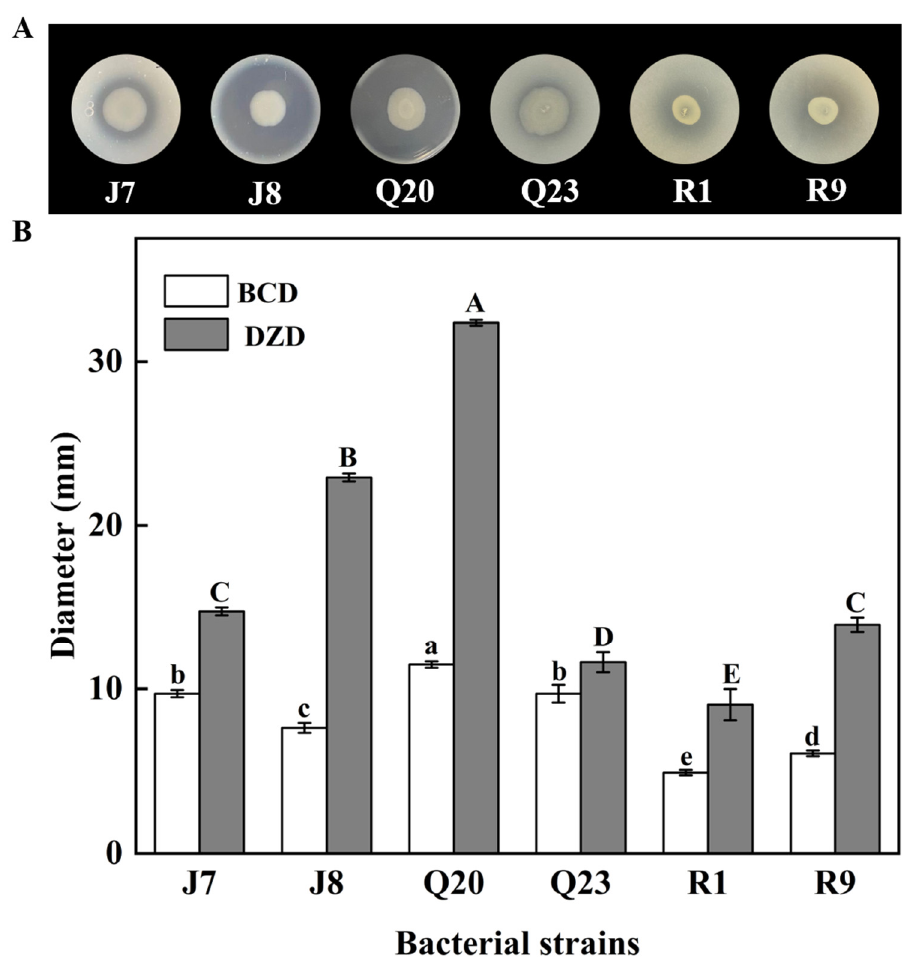
Figure 1. Proteolytic circle on skim milk agar ( A ), DZDs and BCDs ( B ) of P. lundensis J7, P. lundensis J8, A. hydrophila Q20, A. media Q23, B. thermosphacta R1, and B. thermosphacta R9. Different capital and lowercase letters represent significant differences of DZDs and BCDs ( p < 0.05).